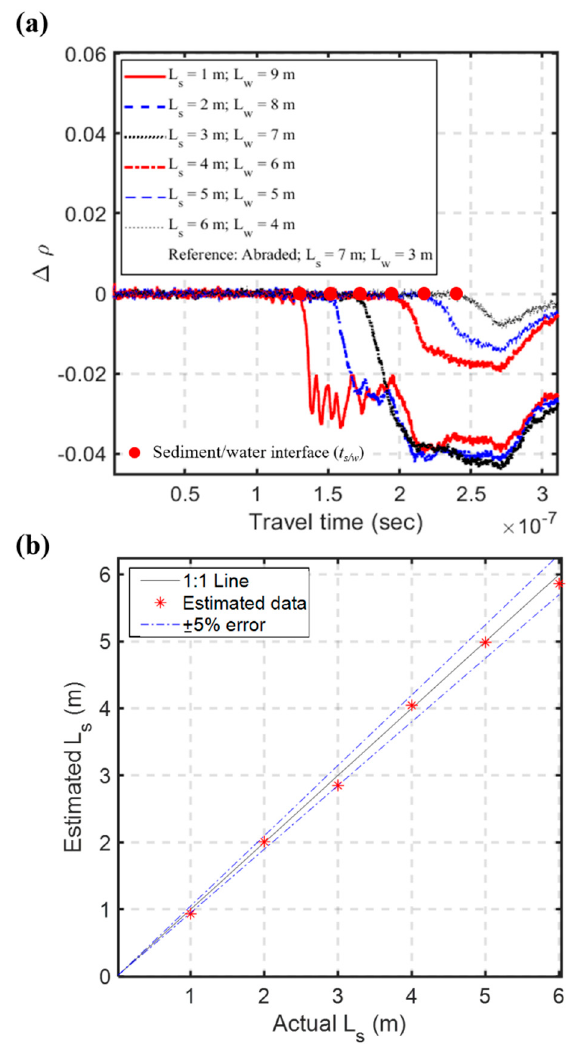
Figure 15. ( a ) Time-lapse differential waveforms after updating the reference waveform with the one after the coating abrasion and sediments refilled to L s = 7.0 m; and ( b ) the estimated Ls considering recalibration of vs. for the refilled sediments.